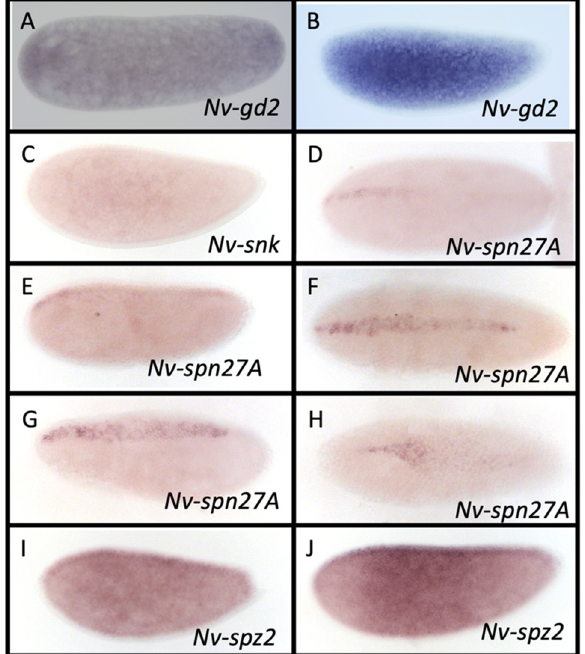
Figure 4. mRNA expression of proteolytic cascade components during N. vitrpennis embryogenesis. Nv-gd2 is initially expressed ubiquitously at low levels in the pre-blastoderm stages ( A ) before being restricted from the cortex and having elevated expression in the cytoplasm/yolk of the syncytial blastoderm ( B ). ( C ) Nv-snk is expressed ubiquitously at low levels in the early (pre- to early blastoderm (shown)) embryo. ( D – H ) Nv-spn27A is initially expressed in a narrow, anterior stripe along the dorsal midline ( D ) before elongating to the posterior pole during the late syncytial blastoderm stage ( E ). The stripe later retracts from the posterior pole ( F ), expands laterally ( G ), and finally becomes localized to the presumptive extraembryonic material after gastrulation ( H ). ( I , J ) Nv-spz2 is ubiquitously expressed throughout the early blastoderm embryo, with elevated expression along the dorsal midline ( I ). Elevated expression then expands laterally, creating a broad ring around the entire circumference of the embryo, from the thoracic to the anterior abdominal segments at the late blastoderm stages ( J ). Anterior is to the left and dorsal is at the top (except in D , F , and H ; dorsal views).